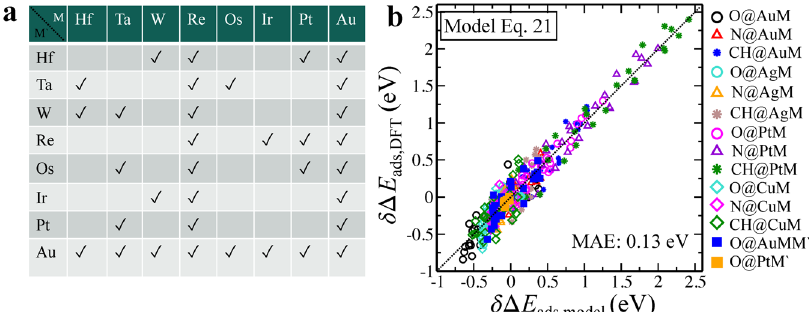
Fig. 10 Parity plot showing the transferability of our model across mixed surface alloys. a Depicts the randomly selected Au-based mixed surface and subsurface alloys, AuMM`. Here, M and M` represent the guest atoms in the subsurface and surface layer, respectively. b Chemisorption energies ( δ Δ E ads,model ) predicted by the model in Eq. (21) plotted against adsorption energies obtained from DFT calculations, ( δ Δ E ads,DFT ). Both NSA, SA and mixed alloys are included in the plot. The black dotted line indicates parity. We have provided all DFT energies of the bare and adsorbed systems and adsorbates in Supplementary Tables 8 –